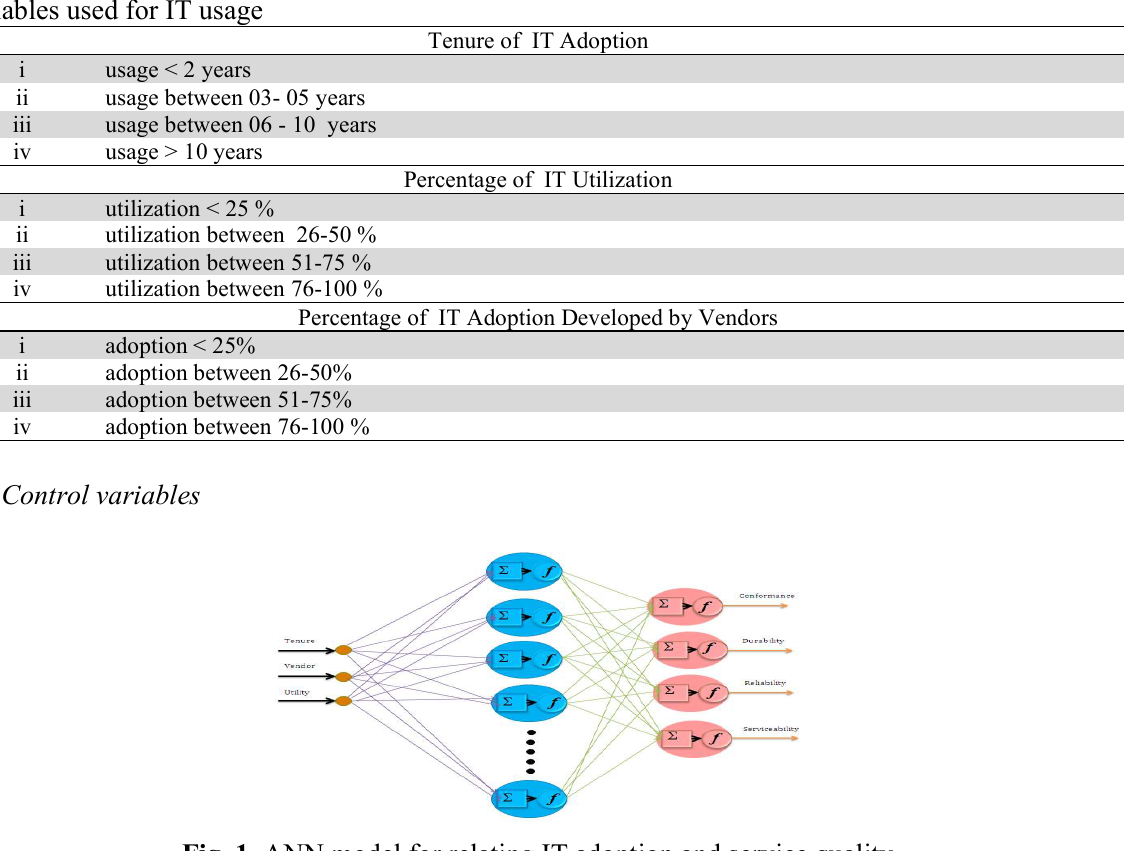
Fig. 1. ANN model for relating IT adoption and service quality